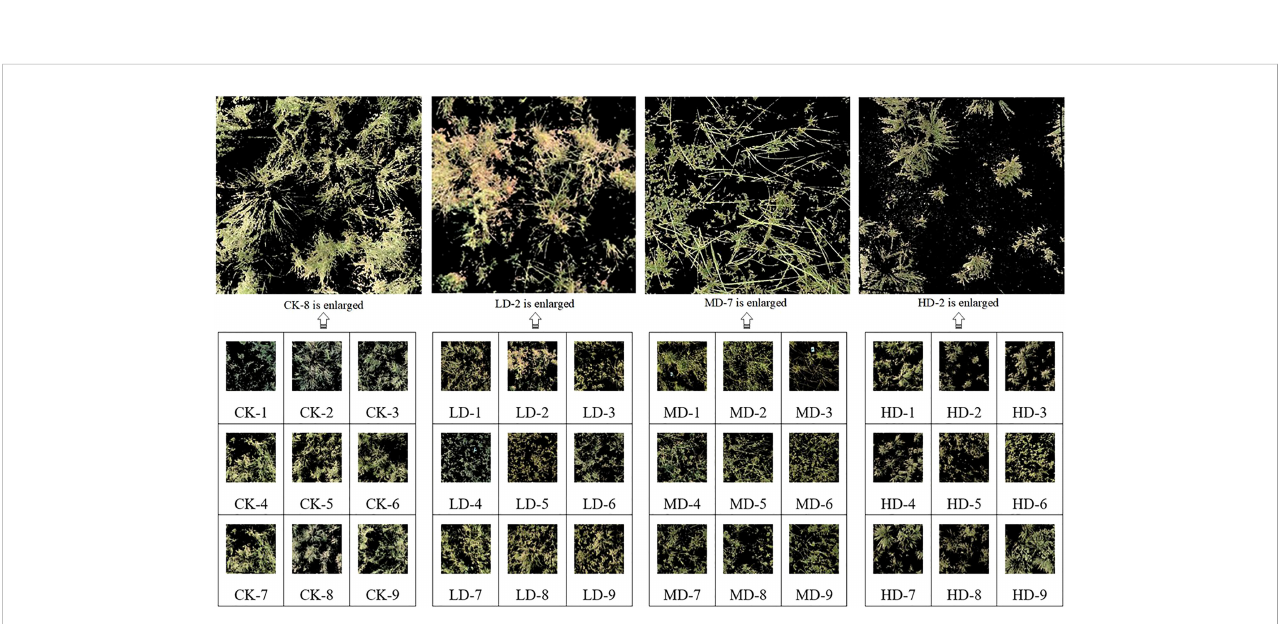
FIGURE 4 Quadrat image segmentation